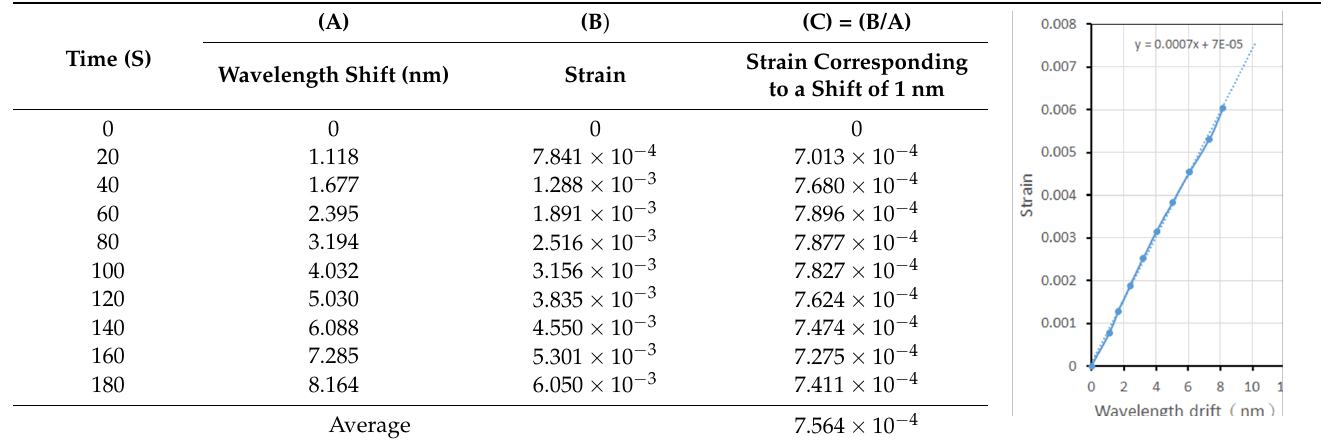
Figure 2. Schematic diagram of relationship between the wavelength shift and strain of the FBG sensor in the tensile test. Table 1. Relationship between the wavelength shift and strain of the FBG